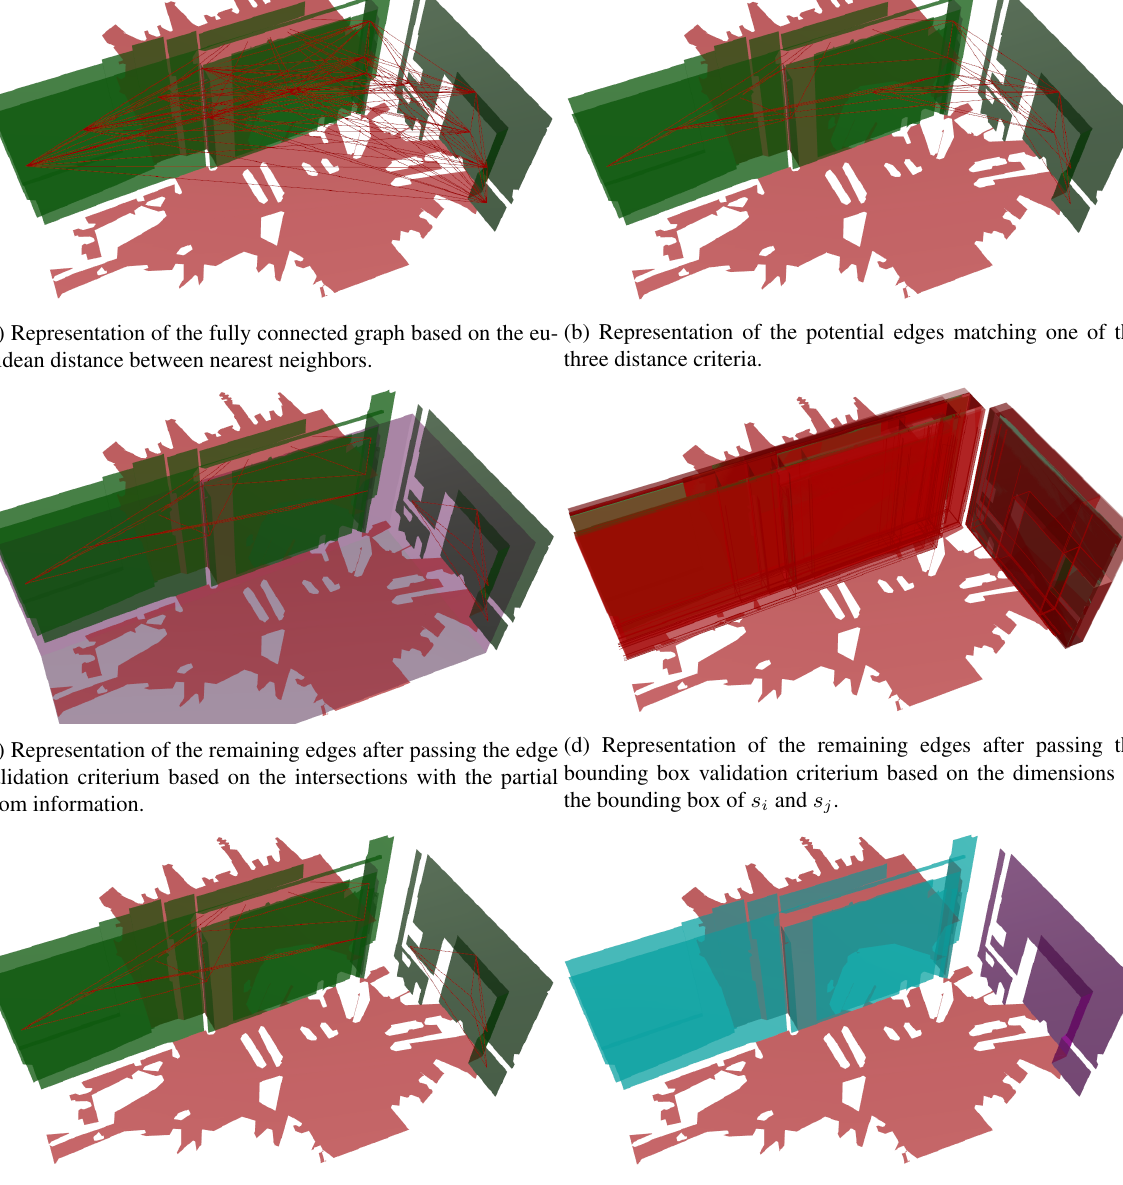
(e) Representation of the connected component graphs based on the remaining edges. Figure 2: Workflow of the graph based wall segments clustering depicting the consecutive steps. The wall segments are shown in green, floor segments in red and graph edges in